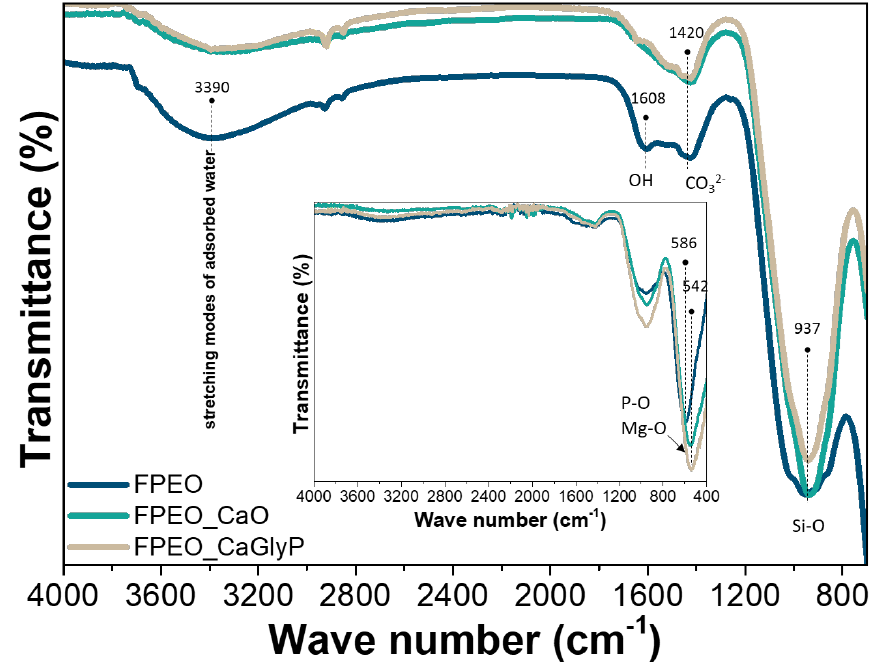
Figure 6. ATR FTIR microscopy spectra and the ATR FTIR spectra (inset) of the flash-PEO coatings.